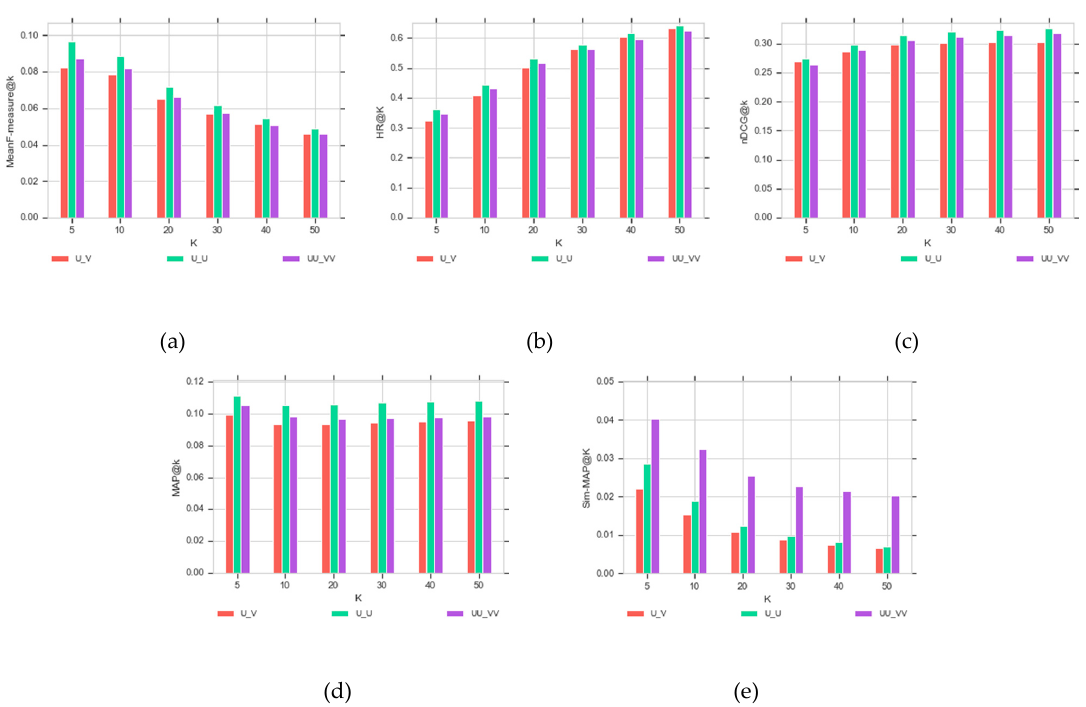
Figure 4. Performance of the random walk with restart (RWR) algorithm in different number of recommendations as measured by different evaluation metrics: ( a ) Mean F-measure@K; ( b ) HR@K; ( c ) nDCG@K; ( d ) MAP@K; ( e ) Sim-MAP@K. HR: hit rate, nDCG: Normalized Discounted Cumulative Gain, MAP: mean average precision.